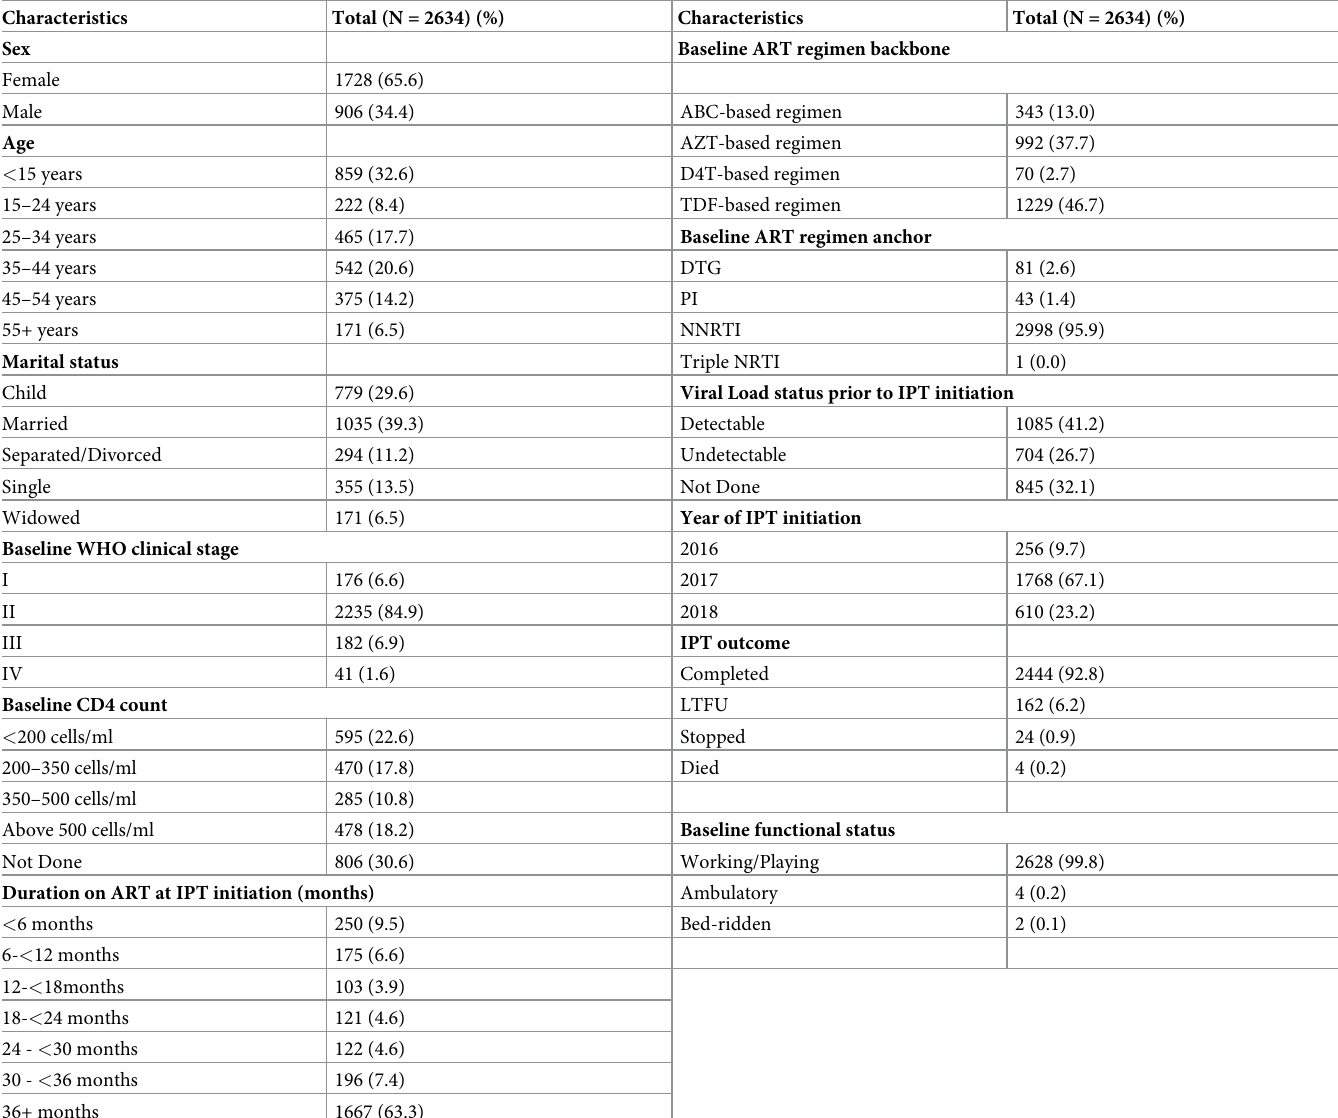
Table 2. Distribution of demographic and clinical characteristics of the study participants.